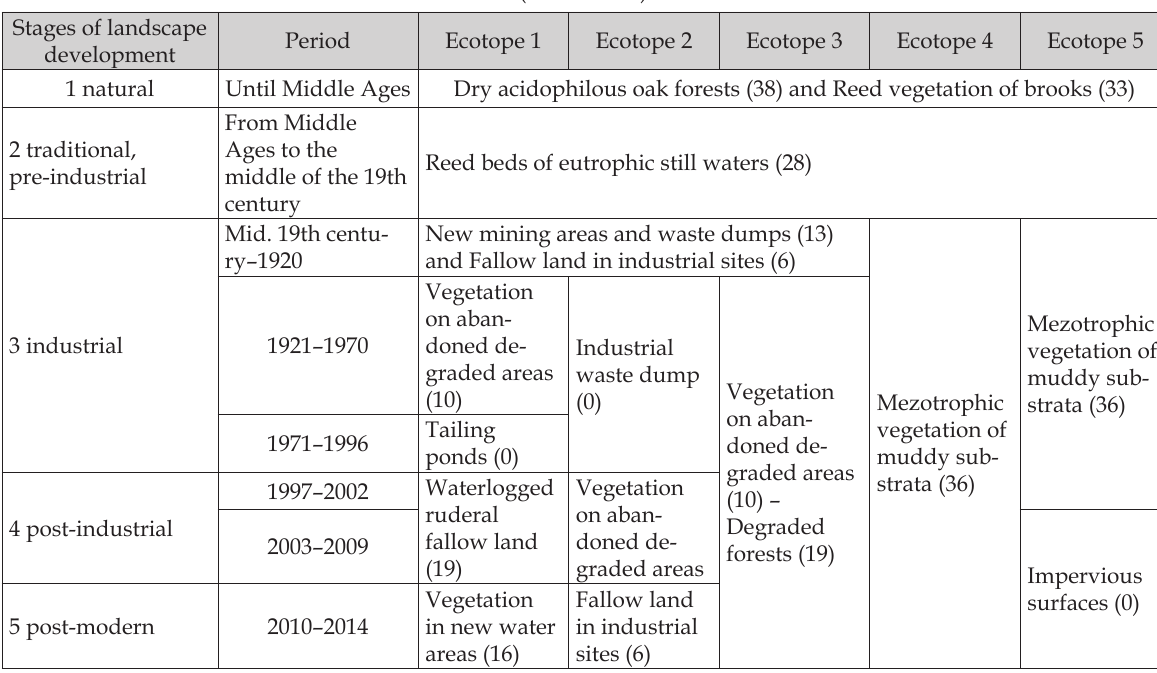
Table 3. Development of ecotopes according to the category and point value of the ecological condition (in